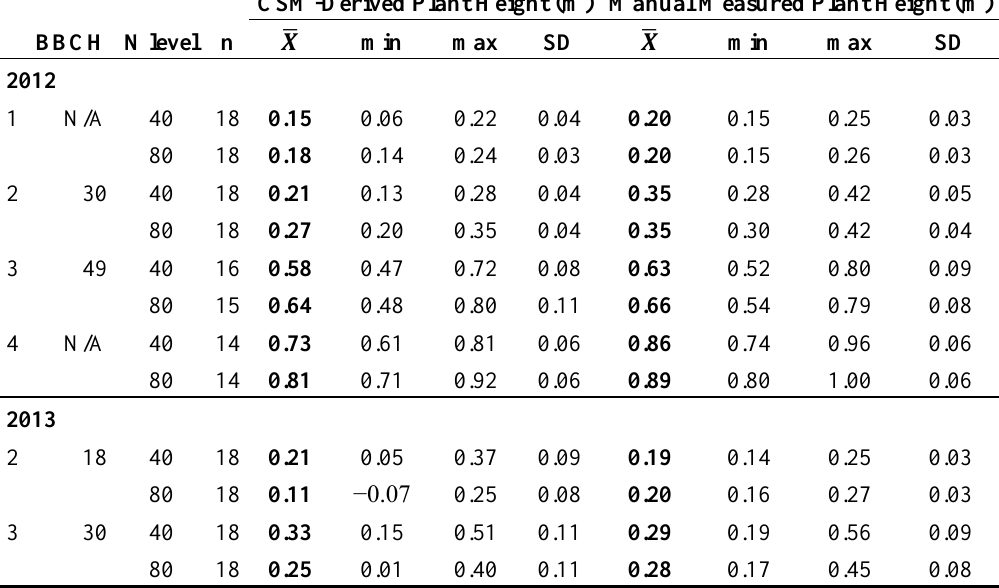
Table A1. Statistics for the plot-wise averaged CSM-derived and manual measured plant heights (n: number of samples; 𝑋̅ : mean value; min: minimum; max: maximum; SD: standard